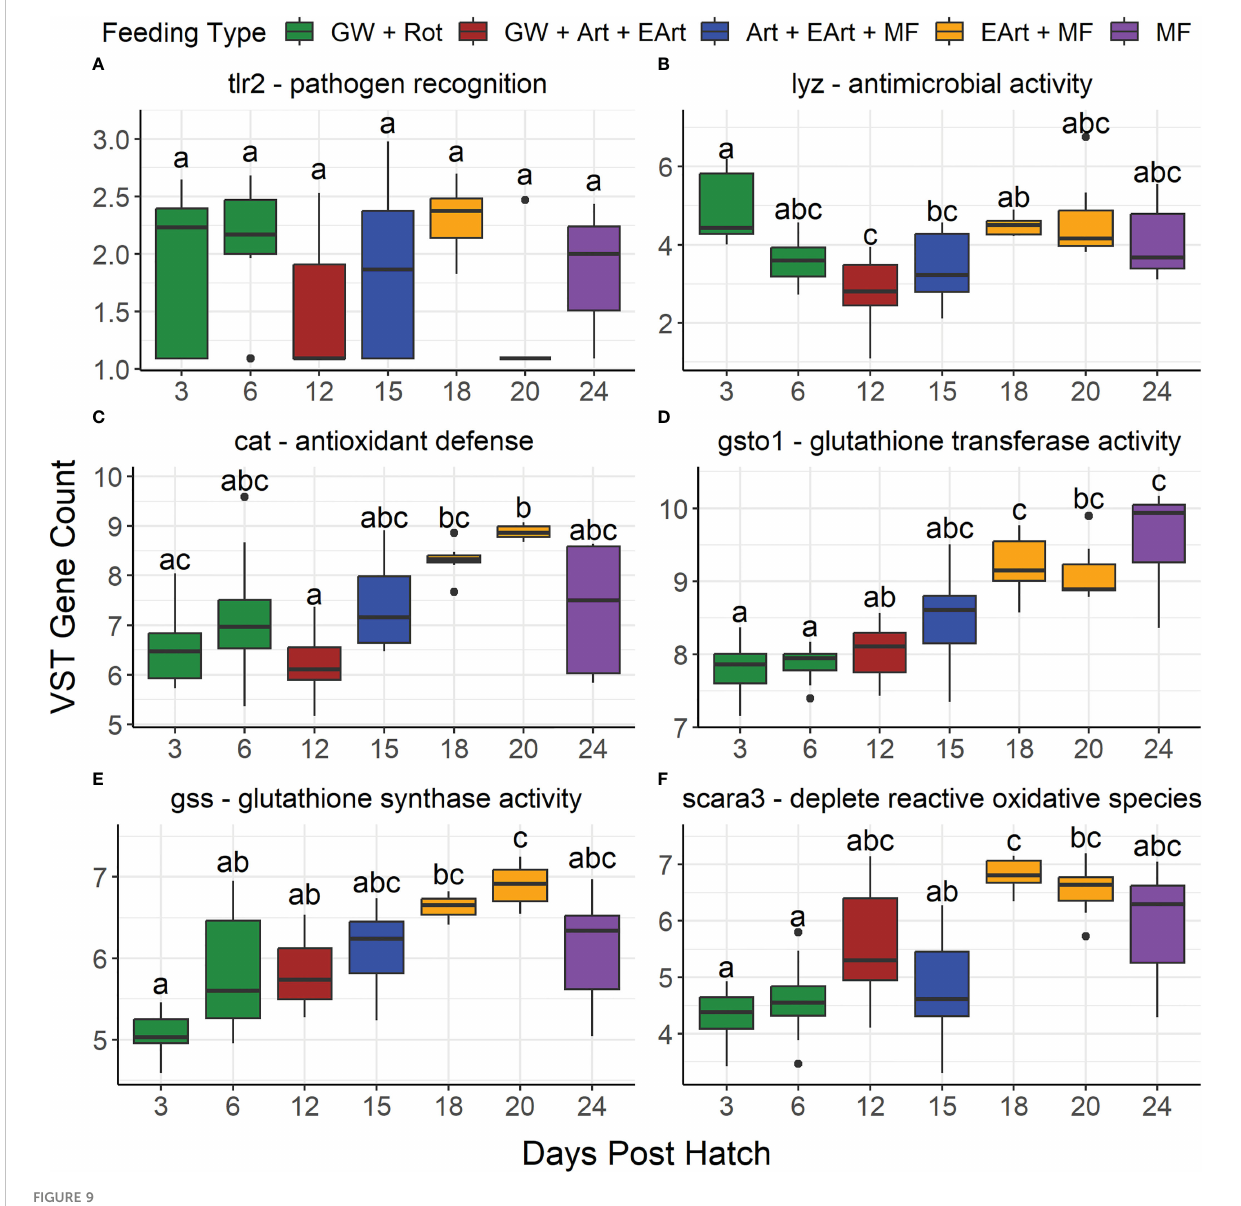
FIGURE 9 Boxplots show the variance stabilizing transformed gene counts of six immune-related genes found in the literature to be differentially expressed based upon salinity differences grouped by days post hatch. These genes include: (A) toll-like receptor 2 (tlr2), (B) lysozyme (lyz), (C) catalase